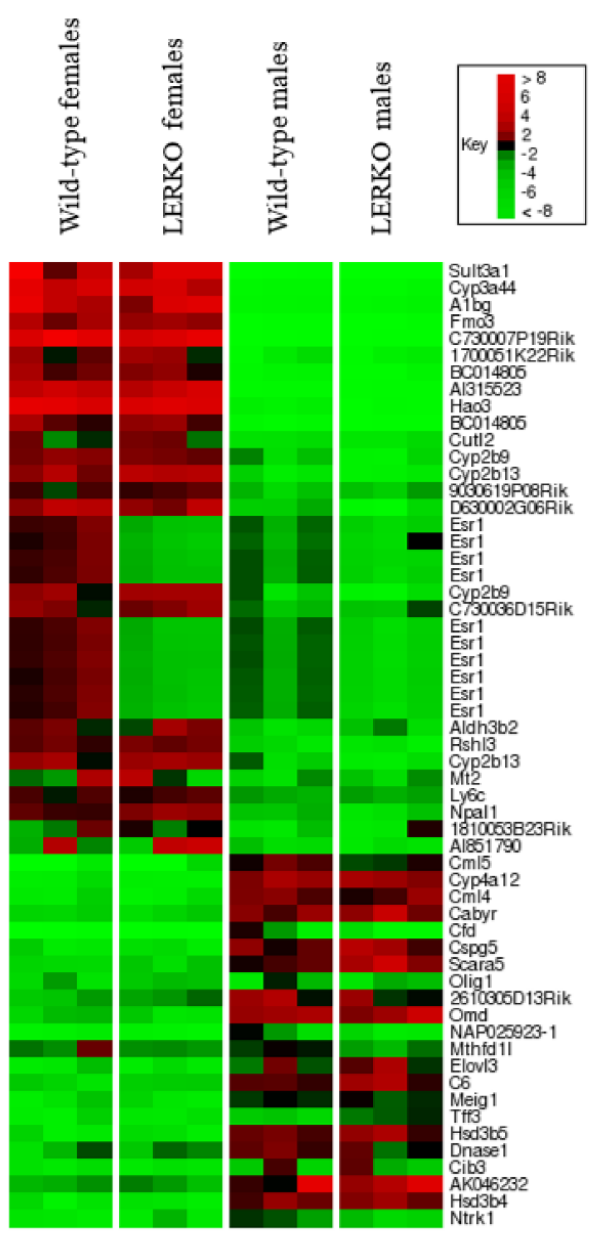
Figure 5. Hepatocyte-specific loss of Estrogen Receptor- α has little effect on sex-specific liver gene expression. This heat map shows gene expression associated with hepatocyte-specific loss of Estrogen Receptor- α (LERKO). Transcripts differing ≥ 5-fold in the global Estrogen Receptor- α knockout female group compared to WT females are shown. Each lane represents microarray results from individual mice sacrificed at 9–10 weeks of age. A single array was run for each animal. Lane 1: wild-type (WT) female littermates ( n = 3). Lane 2: Female LERKO mice ( n = 3). Lane 3: WT male littermates ( n = 3). Lane 4: Male LERKO mice ( n =